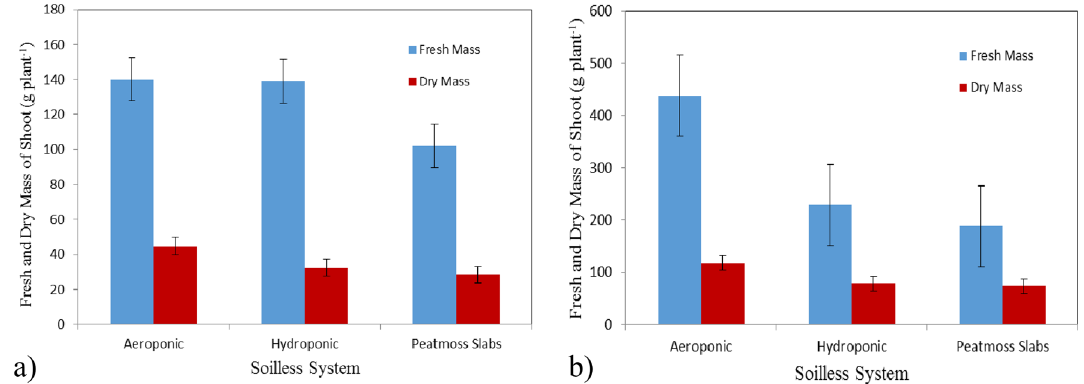
Figure 5. Fresh and dry mass of shoot of basil plants, ( a ) at vegetative stage, and ( b ) at flowering stage.